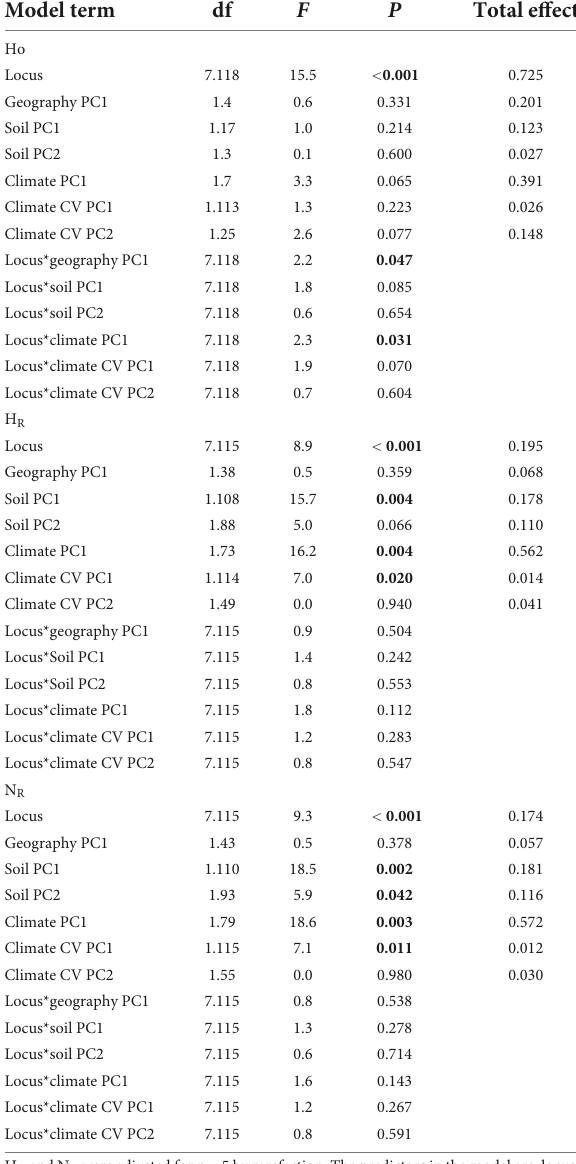
TABLE 3 Mixed-model results (coefficient ± SE, F, P, and total effect) for observed heterozygosity (Ho), Shannon’s diversity (H R ), and allelic richness (N R